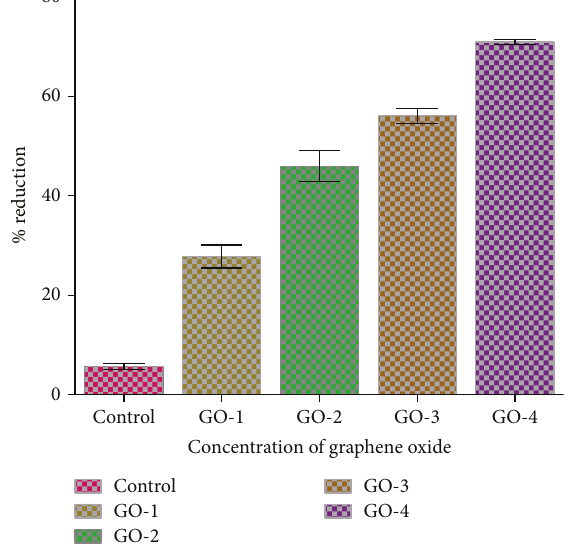
Figure 9: Antibacterial activity of various graphene oxide (GO) concentrations against S. typhi .